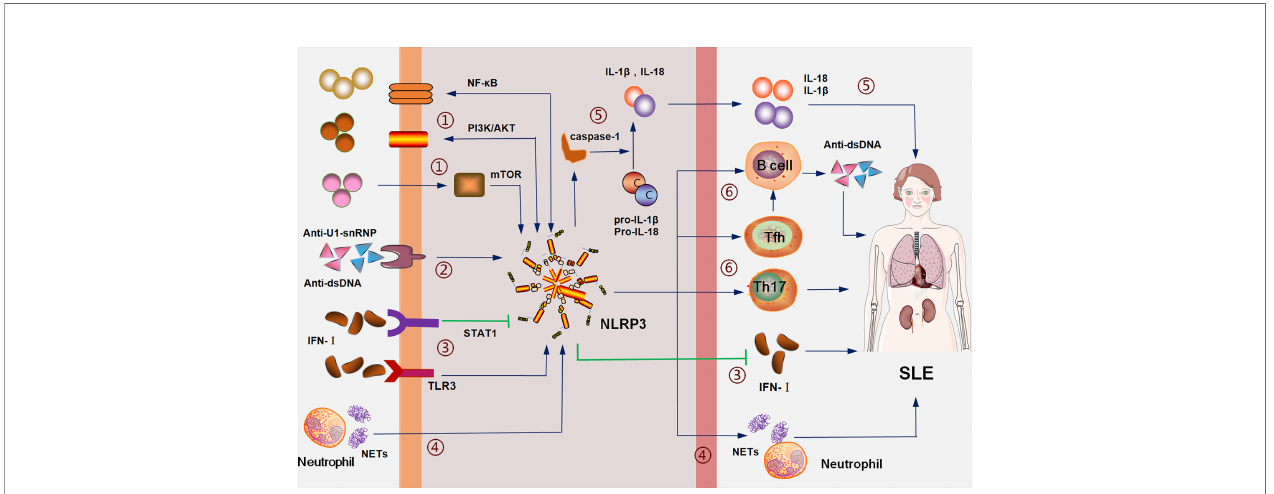
FIGURE 1 | The NLRP3 in fl ammasome is involved in the pathogenesis of SLE: (1) interacts with SLE pathogenic signals, such as NF-KB, PI3K/AKT and mTOR; (2) mediates the in fl ammation of pathogenic antibodies including anti-dsDNA; (3) IFN-I activates NLRP3 in fl ammasome through the TLR3 pathway and inhibits NLRP3 in fl ammasome through the STAT1 pathway; NLRP3 inhibits the expression of IFN-I; (4) neutrophil NETs activate the NLRP3-associated in fl ammation, which, in turn, induces the formation of NETs; (5) the NLRP3 in fl ammasome promotes the maturation and secretion of IL-1 b and IL-18 through caspase-1; (6) the NLRP3 in fl ammasome promotes the proliferation and activation of Th17, Tfh, and B cells to mediate the disorder of cellular immune balance and promote the production of antibodies.